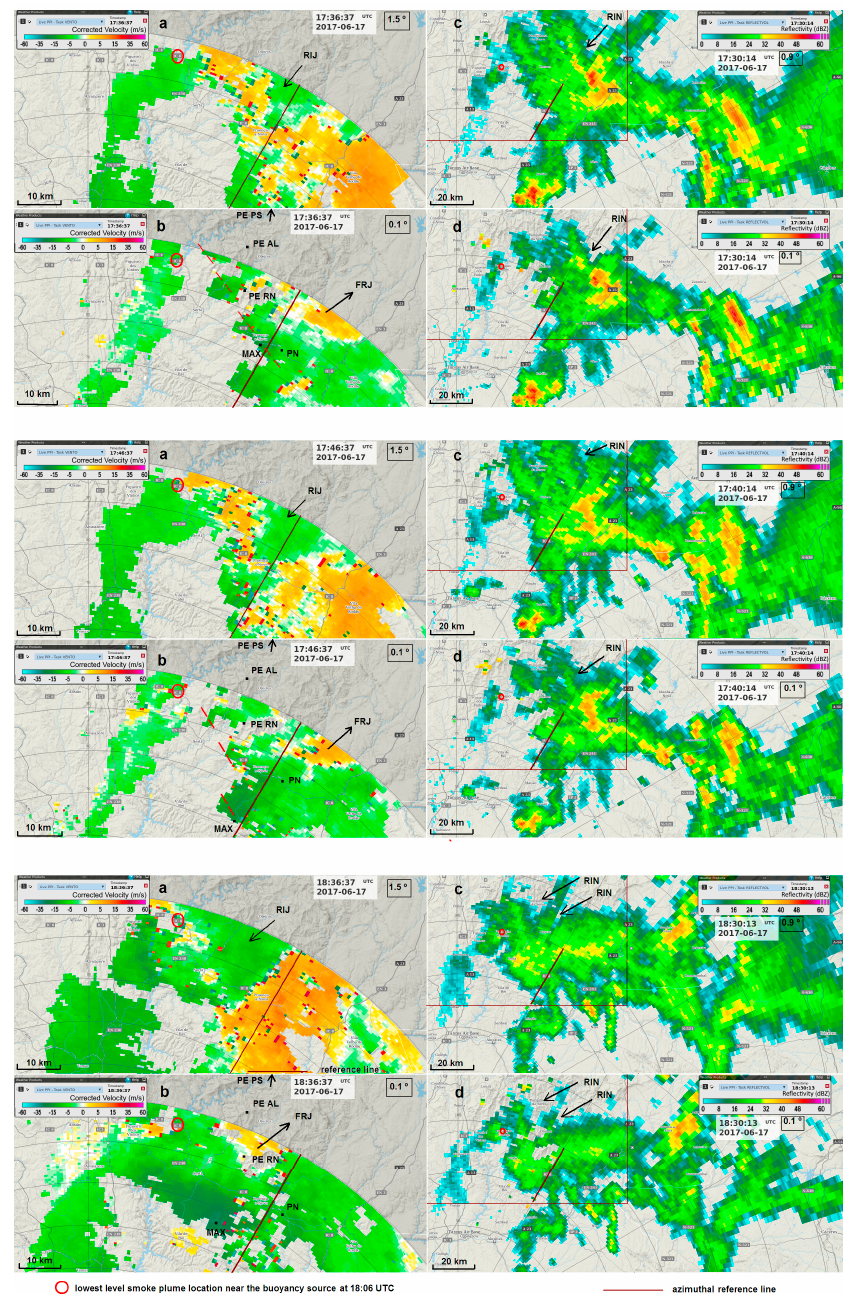
Figure 12. PPI of storm-relative velocity, 1.5 ◦ tilt ( a , e , i ), 0.1 ◦ tilt ( c , g , k ); PPI of reflectivity, 0.9 ◦ tilt ( b , f , j ), 0.1 ◦ tilt ( d , h , l ). Lines in ( b , d , f , h , j , l ) delimit the insertion of the observed area in ( a , c , e , g , i , k